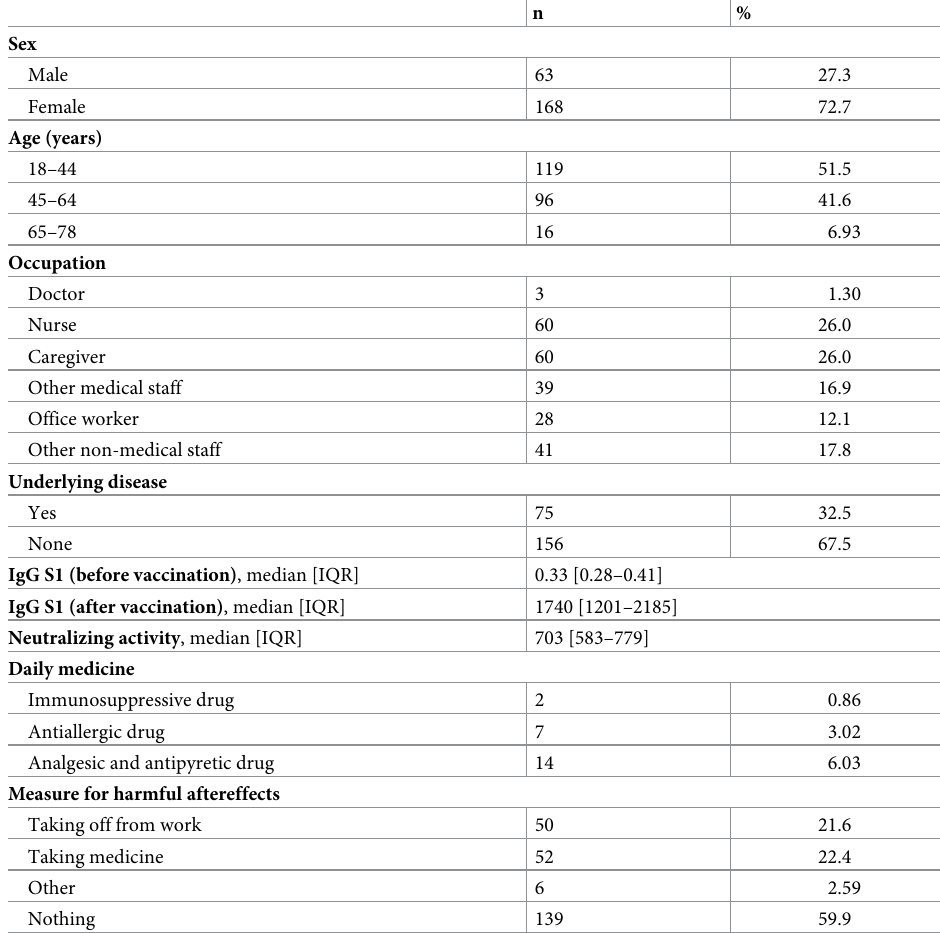
Table 1. Characteristics of the participants (n =